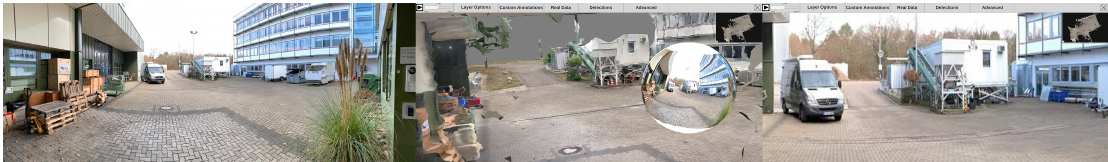
Figure 16. Panoramas ( Left ) are displayed as spheres in the scene ( center ). By opening a sphere, the user “enters” the photosphere to inspect it ( right